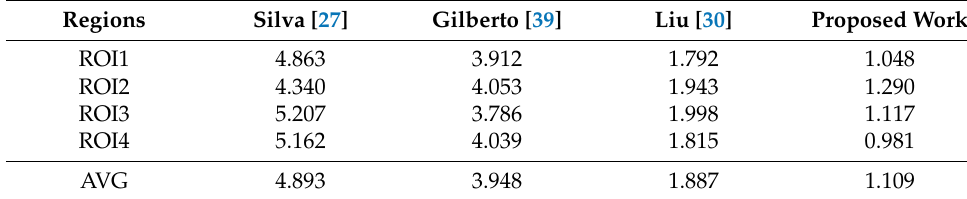
Table 2. Quantitative evaluation results of color difference (CD).